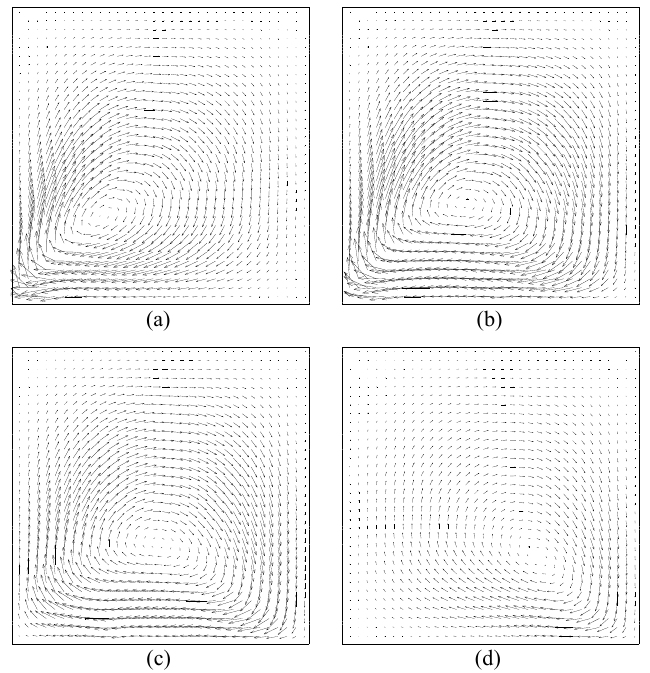
Figure 6. Flow fields for different locations of the magnet with Br = 2.0 T; ( a ) x m / L = 0.2, ( b ) x m / L = 0.4, ( c ) x m / L = 0.6, and ( d ) x m / L = 1.0.